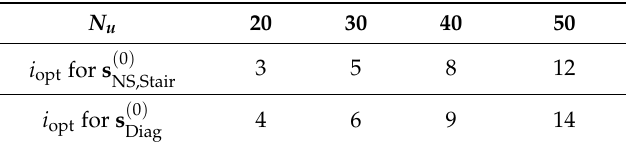
Table 5. The number of optimal iterations i opt for GS pre-coding when the initial solutions are s ( 0 ) and s Diag